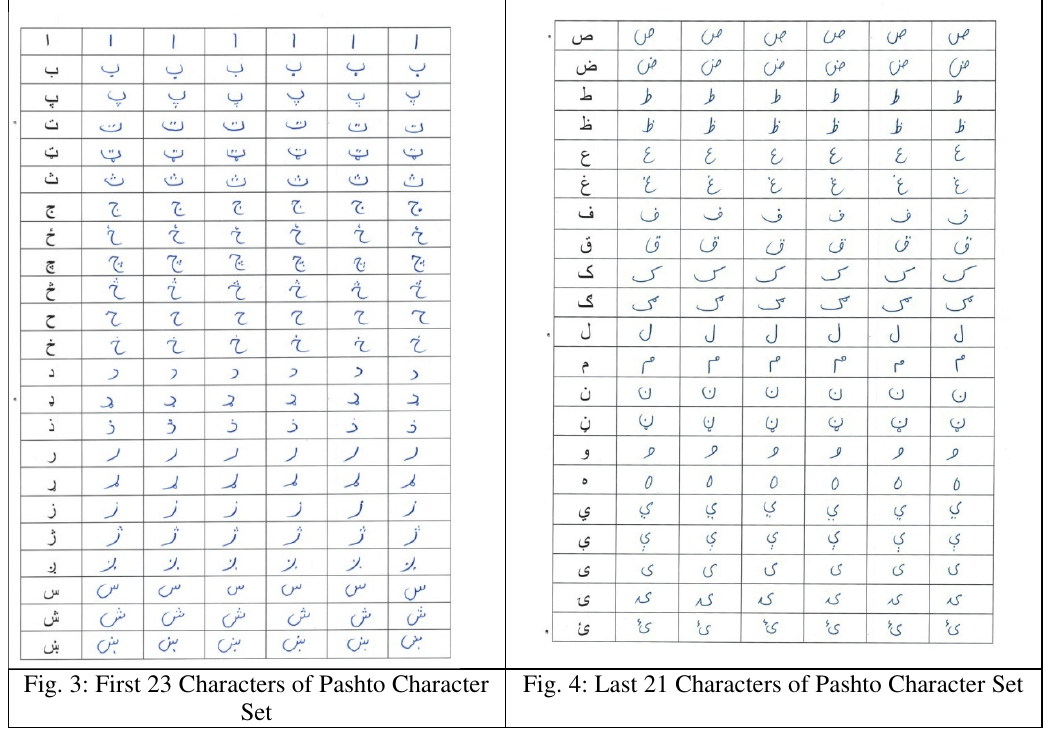
Fig. 3: First 23 Characters of Pashto Character Fig. 4: Last 21 Characters of Pashto Character Set